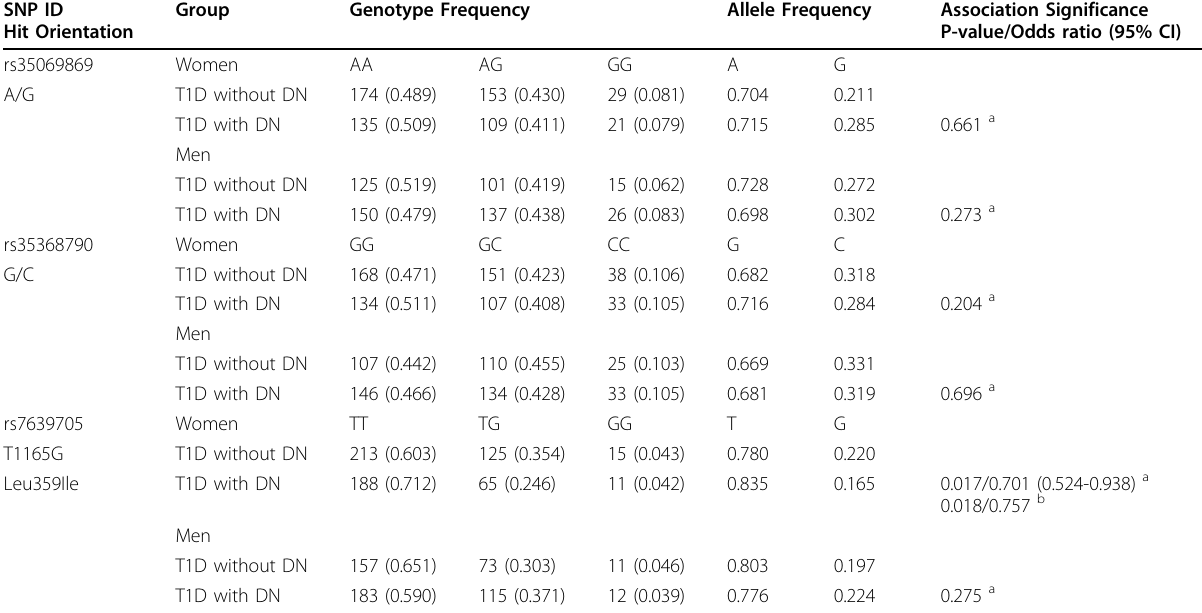
Table 2 Association between the MCF2L2 genetic polymorphisms and diabetic nephropathy SNP ID Group Genotype Frequency Allele Frequency Association Significance Hit Orientation